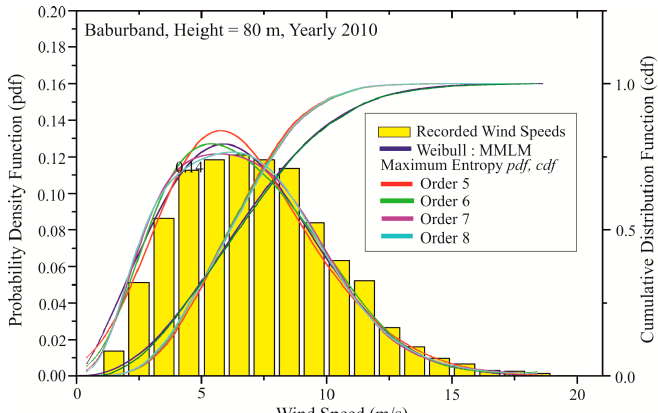
Figure 3. Histogram of the measured wind speed data as a function of wind speed. Probability density and Cumulative distribution curves for Weibull and MEP ‐ based functions are overlapped on the histogram. Weibull pdf & cdf are shown in BLUE whereas pdf & cdf of MEP ‐ based function are shown in RED, GREEN, MAGENTA and CYAN colors for orders 5, 6, 7 and 8, respectively.